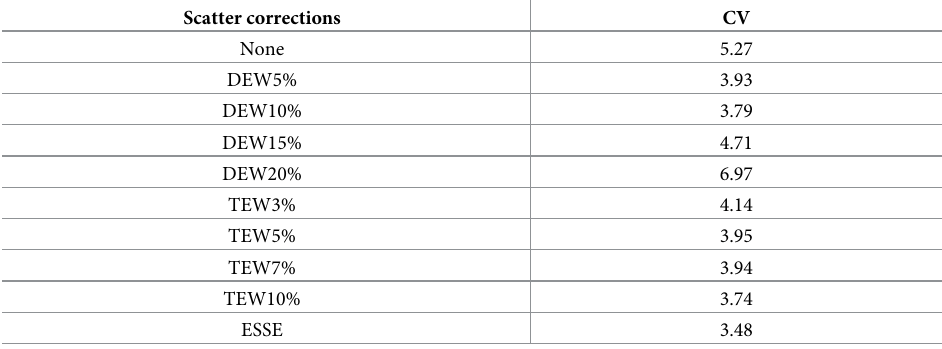
Table 2. Coefficients of variation at center of uniform cylinder